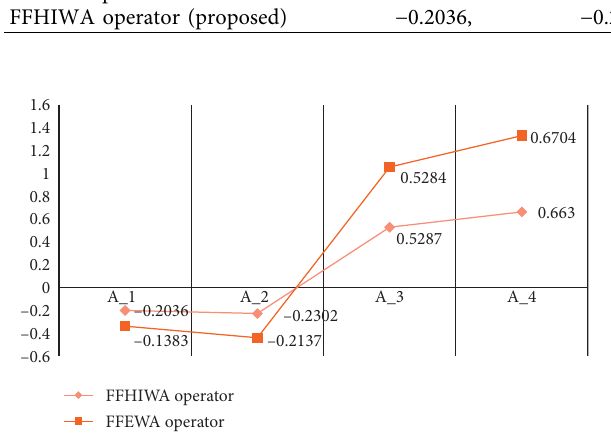
Figure 2: Comparison with FFEWA operator.